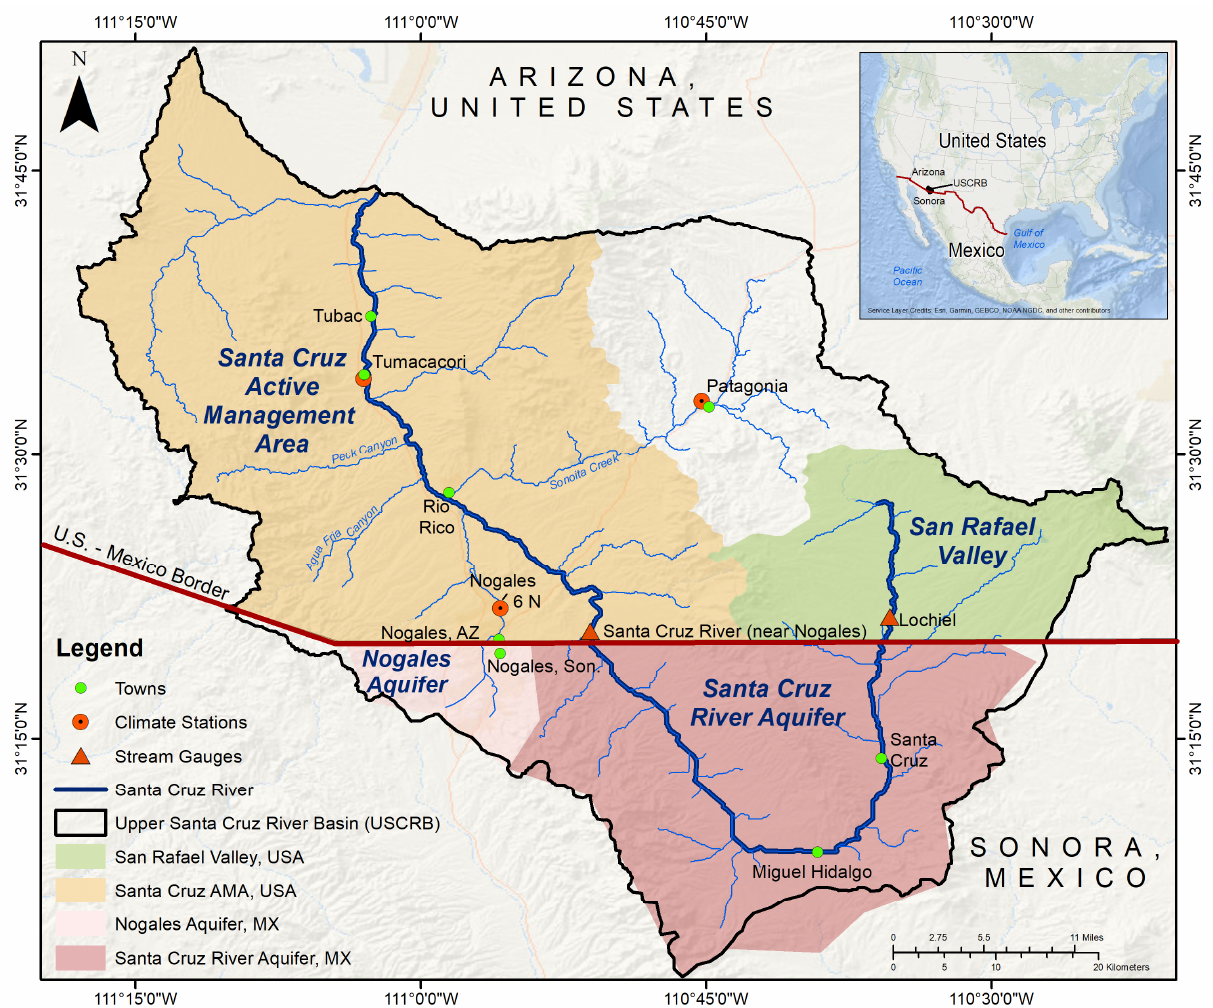
Figure 2. Map of the study region.